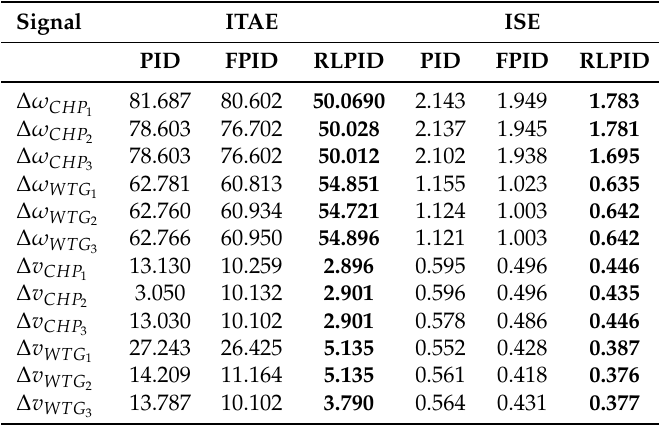
Table 2. Time domain performance indices in scenario